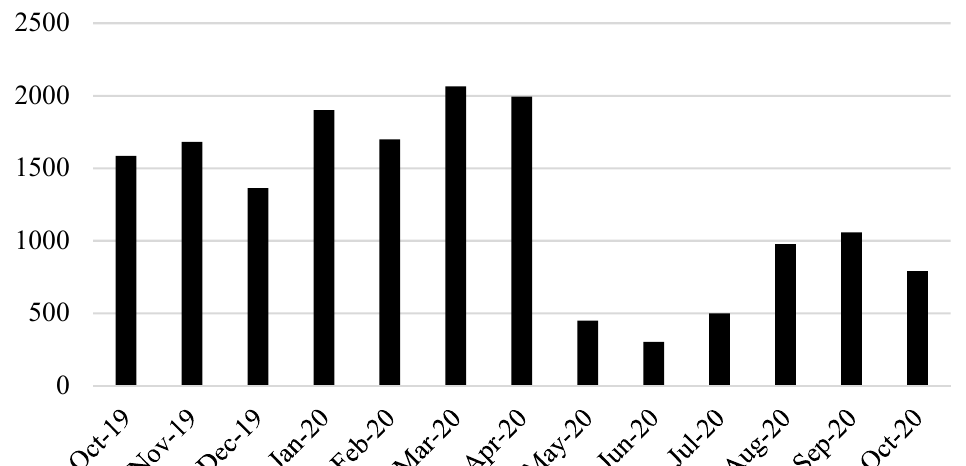
Figure 10. Monthly energy generation from the energy recovery PAT between October 2019 and October